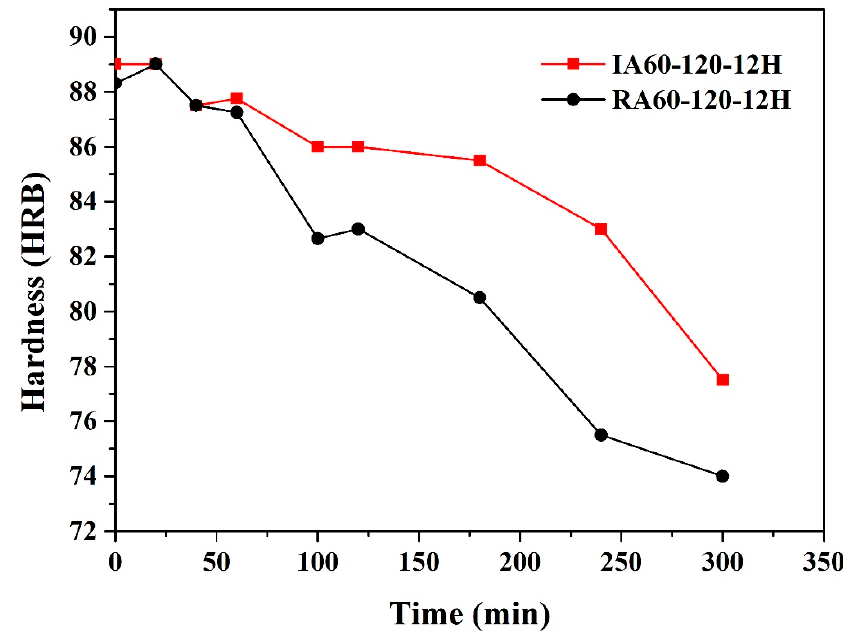
ff ect of heating method on hardness profiles of specimens aged at 200 ◦ Figure 11. Effect of heating method on hardness profiles of specimens aged at 200 °C. Figure 11. E